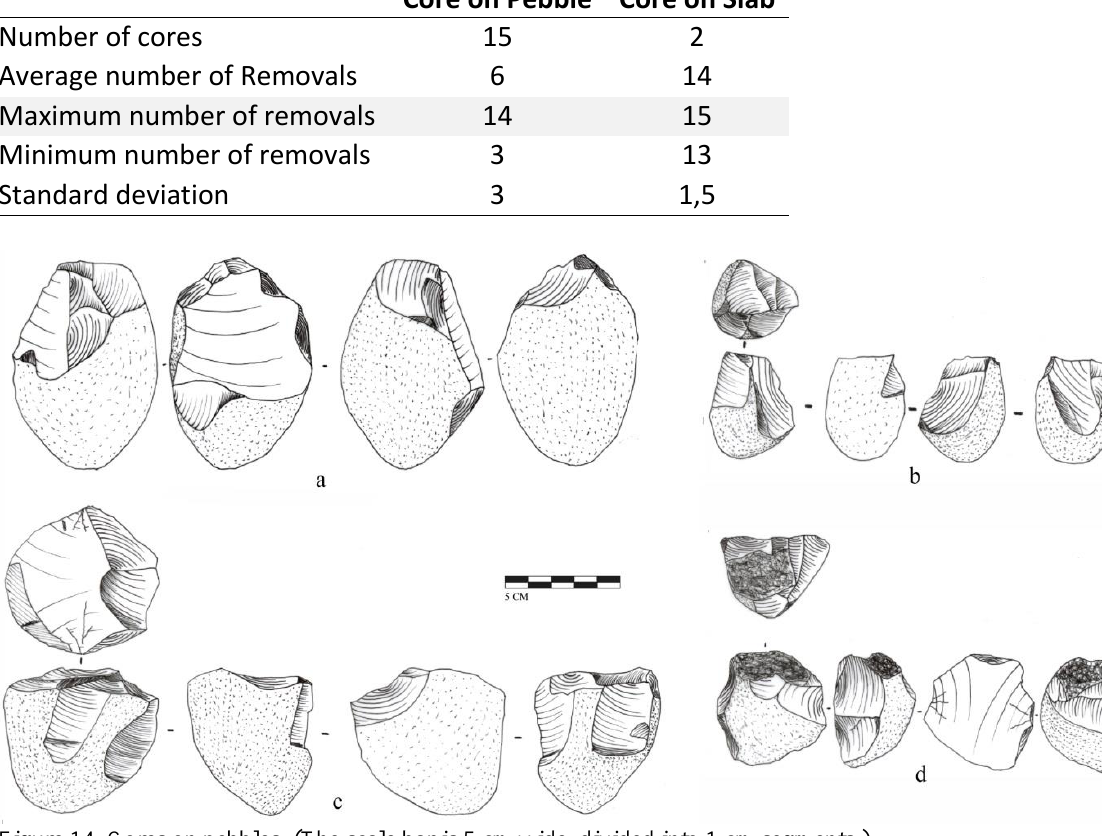
Figure 14. Cores on pebbles. (The scale bar is 5 cm wide, divided into 1 cm